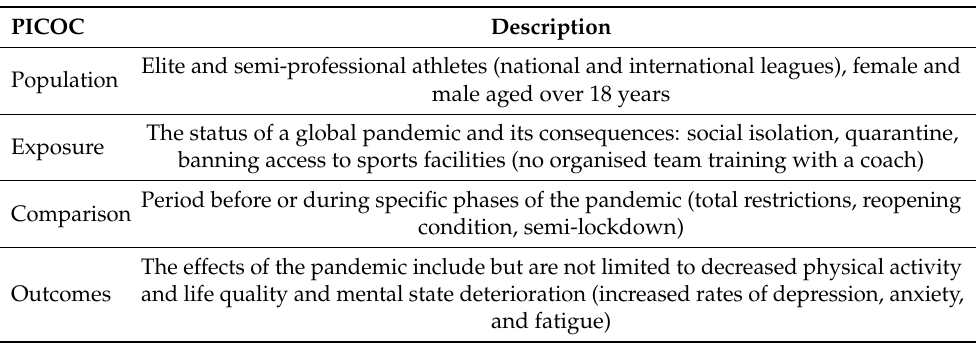
Table 1. Characteristics of qualitative data and search criteria based on the PICO model. PICOC Description Elite and semi-professional athletes (national and international leagues), female and Population Exposure